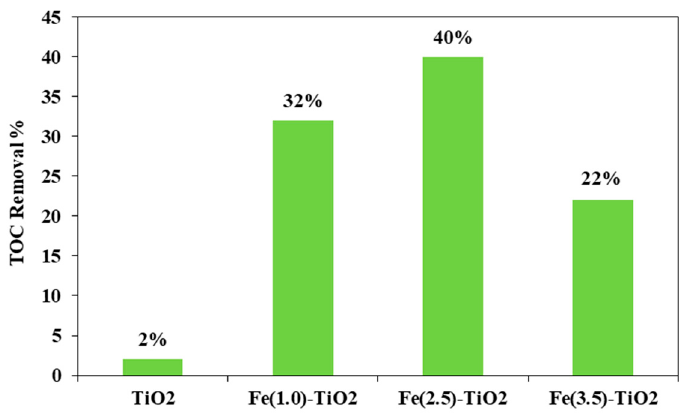
Figure 9. TOC Removal (%) from the AO7 aqueous solution after 180 min of visible using Fe(1.0)-TiO 2 , Fe(2.5)-TiO 2 , Fe(3.5)-TiO 2 , and undoped TiO 2 photocatalysts.